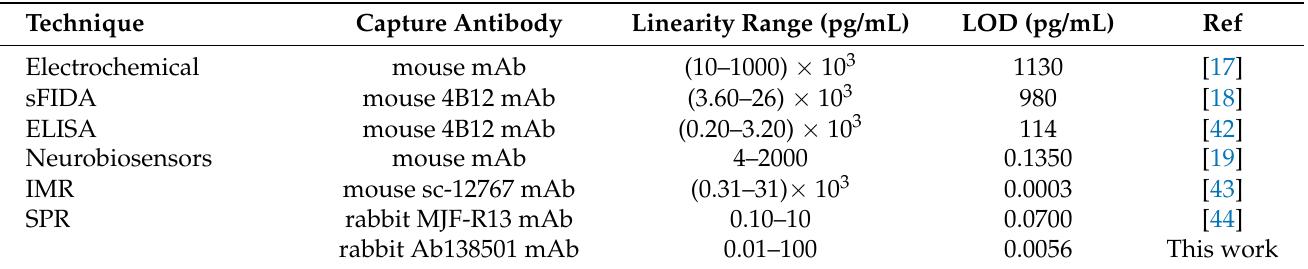
Table 2. Comparison with other analytical techniques based on the antibody for α -syn detection.